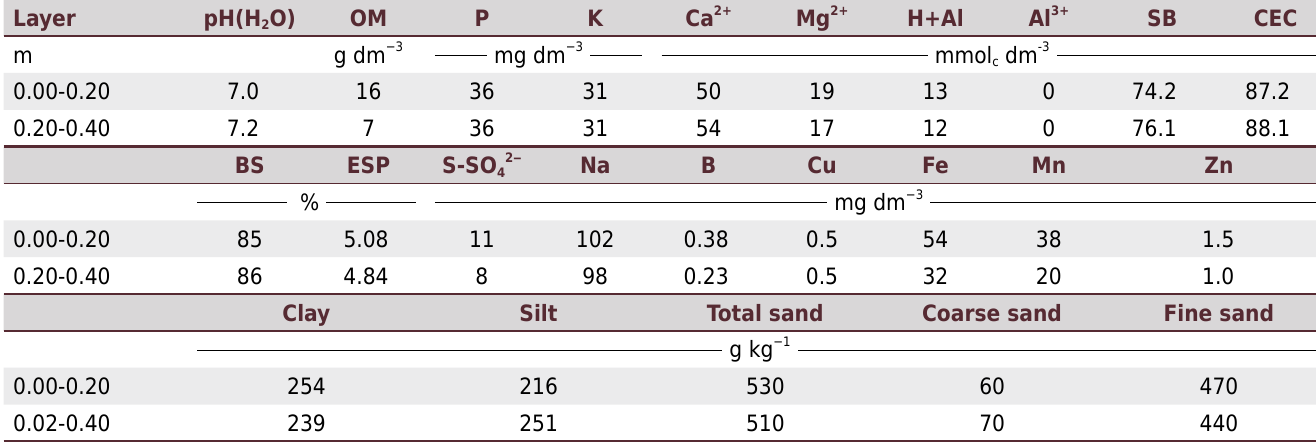
Table 1. Soil chemical and particle-size properties in the experimental area Layer